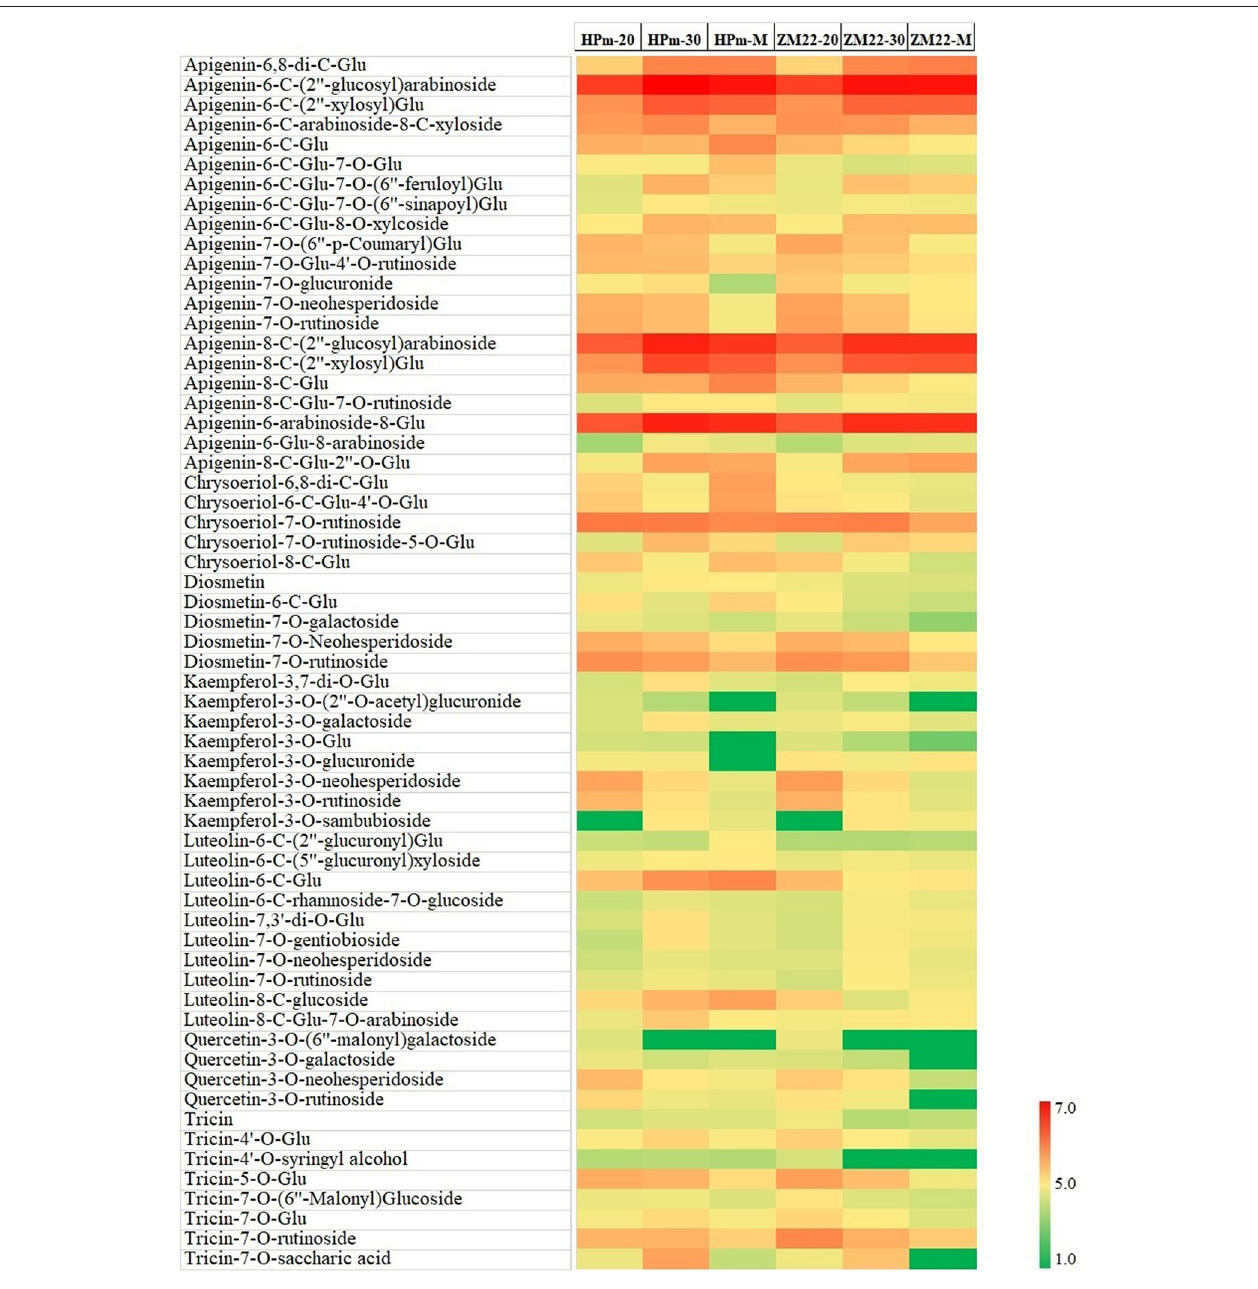
FIGURE 3 | Heat map of differentially expressed flavonoids in wheat grains during grain development. HPm-20, HPm-30, and HPm-M are samples from wheat cultivar HPm512 at 20 days after anthesis (DAA), 30 DAA, and maturity. ZM-20, ZM-30, and ZM-M are samples from wheat cultivar ZM22 at 20 DAA, 30 DAA, and maturity, respectively. Red color represents high relative abundance, and green color represents low relative abundance.